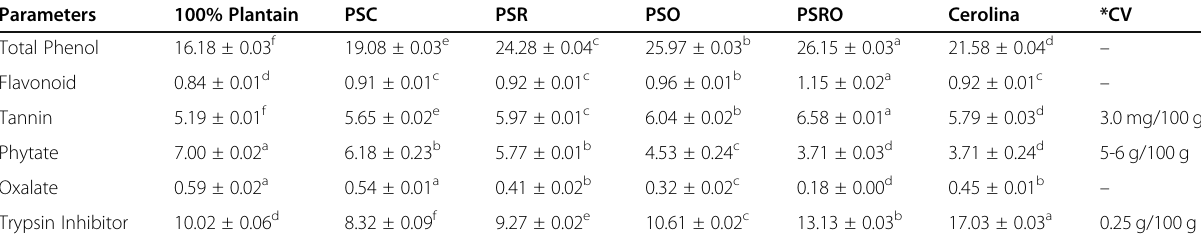
Table 4 Phytochemical composition (mg/g) of plantain, soycake, rice bran and oat bran flour and control samples